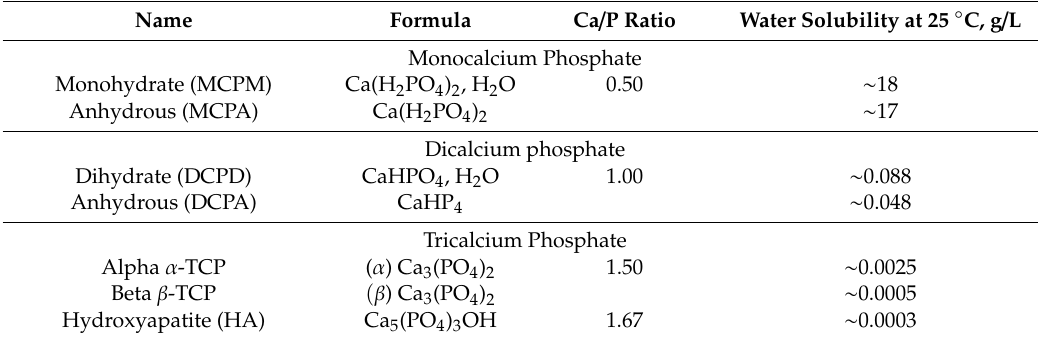
Table 3. Characteristics of main CaPs used as bone substitutes and cements